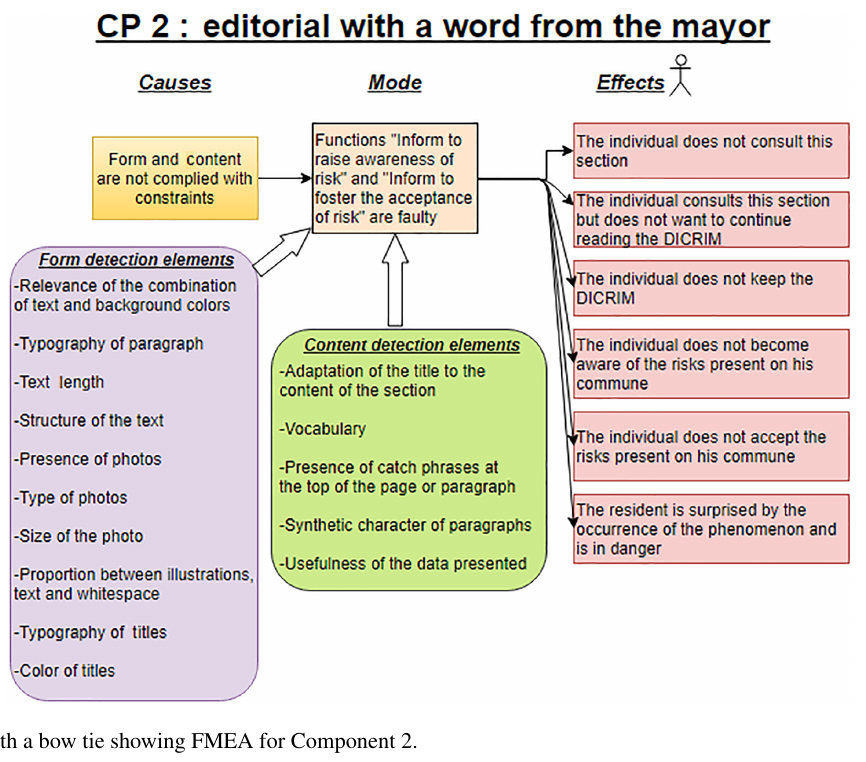
Figure 6. Diagram with a bow tie showing FMEA for Component 2.